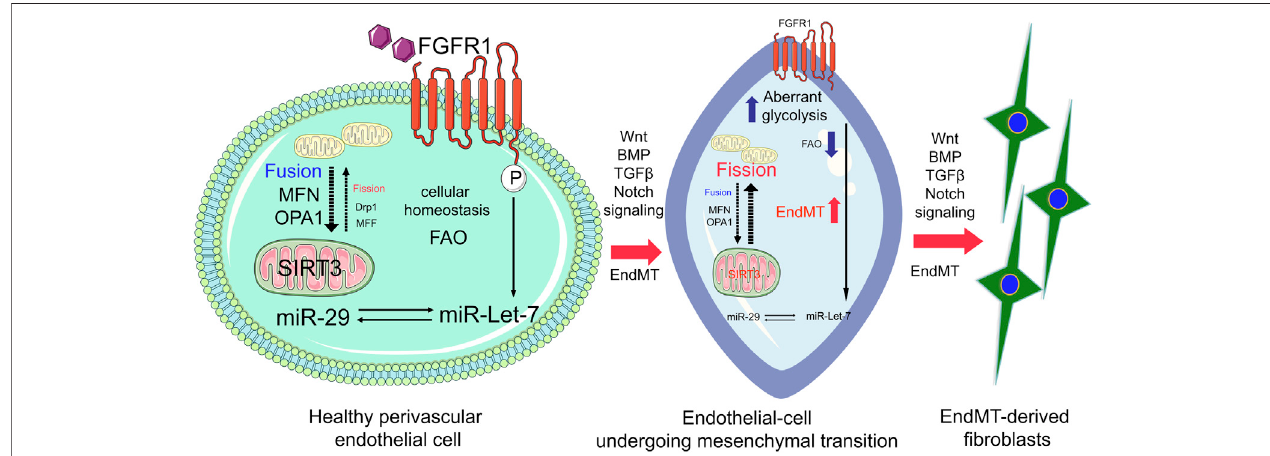
FIGURE2 | FGFR1-miR-let-7 axis maintainsendothelialcell homeostasis by regulating mitochondrial dynamics and integrity through modulating SIRT3.In healthy endothelial cells, FGFR1-miR-let-7 maintains mitochondrial dynamics and in fl uences SIRT3; however, suppression of the FGFR1-miR-let-7 axis disrupts the miR-29 level and SIRT3 level, and ultimately disrupts mitochondrial biogenesis and integrity. Cumulative effects of suppressed levels of FGFR1-miR-let-7 axis and SIRT3 lead to the activation of pro-mesenchymal signaling, Wnt signaling, BMP, Notch, and TGF- β signaling; resulting in EndMT events and accumulation of EndMT-derived myo fi